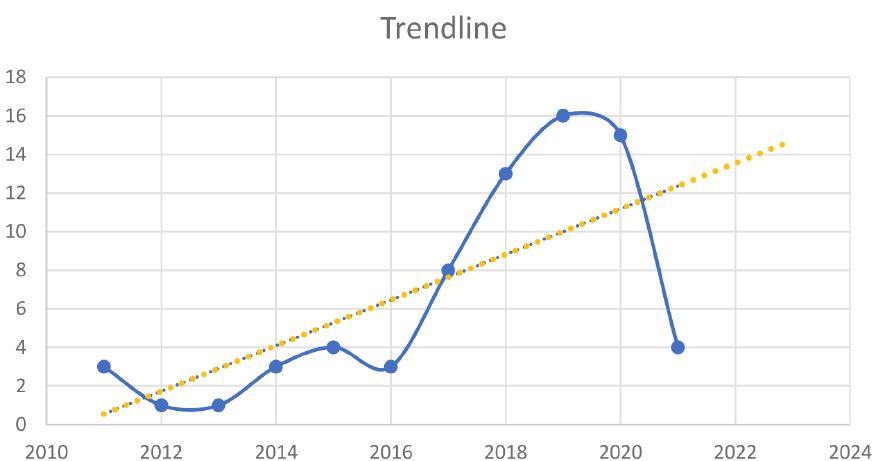
Figure 6. Fire Detection using UAV